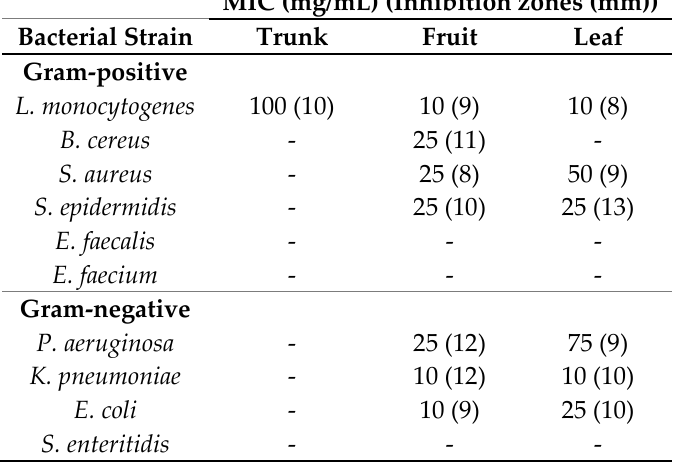
Table 1. Minimum inhibitory concentration (MIC, mg/mL) and inhibition zones (mm) of the phenolic compounds extracted from the Plane tree’s trunk, leaves and fruits against multidrug-resistant